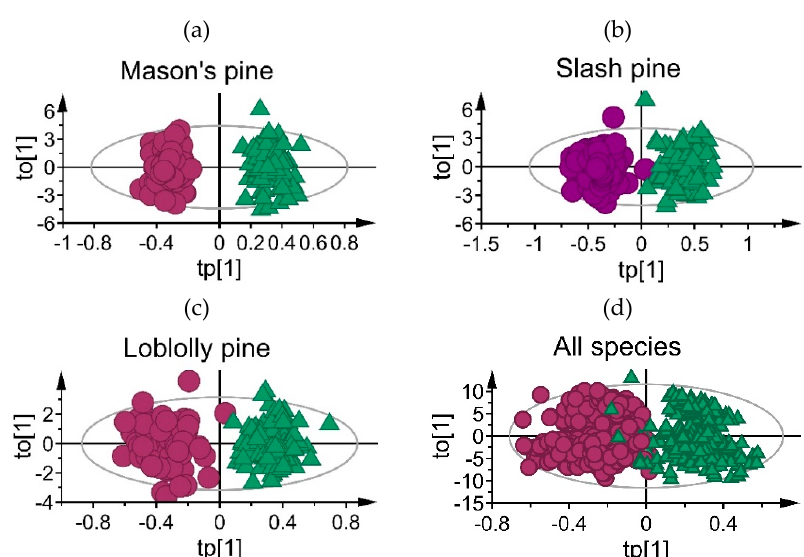
Figure 2. Score plots for the predictive (tp[1]) versus orthogonal (to[1]) components depicting grouping patterns of viable (pink dots) and dead-filled (green triangles) seeds of Mason’s pine ( a ), slash pine ( b ), loblolly pine ( c ) and all species combined ( d ).